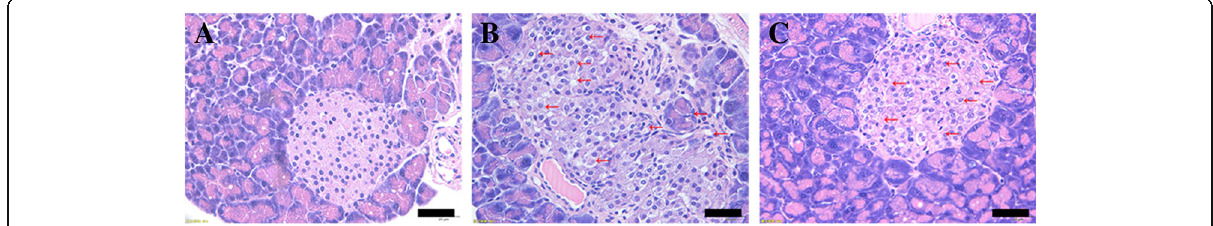
Fig. 3 Effect of WMW on the disordered structure of pancreatic islets in db/db mice. Representative photos of H&E staining from the pancreas of ( a ) wild-type; ( b ) db/db; and ( c ) db/db mice treated with HWMW. Scales were 25 μ m ( n =